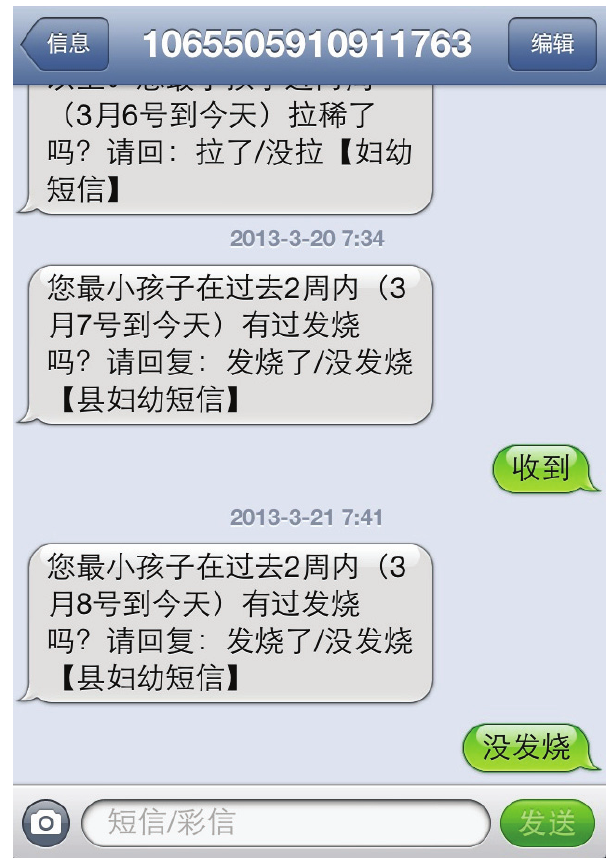
Figure 5. Screen shot of mobile phone. A screen shot of a supervisor’s mobile phone when testing sending of text messages in the morning before the fieldwork of the cross–over study started. The shot is courtesy of Xiaozhen Du, personal